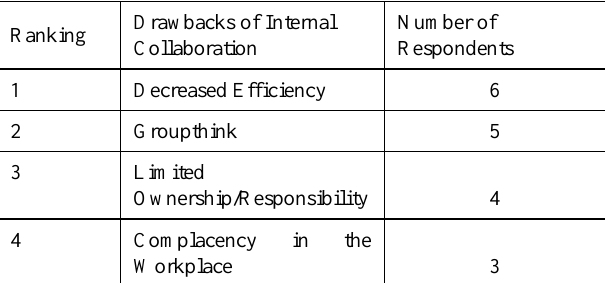
Table 6: Drawbacks of internal collaboration Despite the benefits of collaboration interviewees pointed out four drawbacks of collaboration.